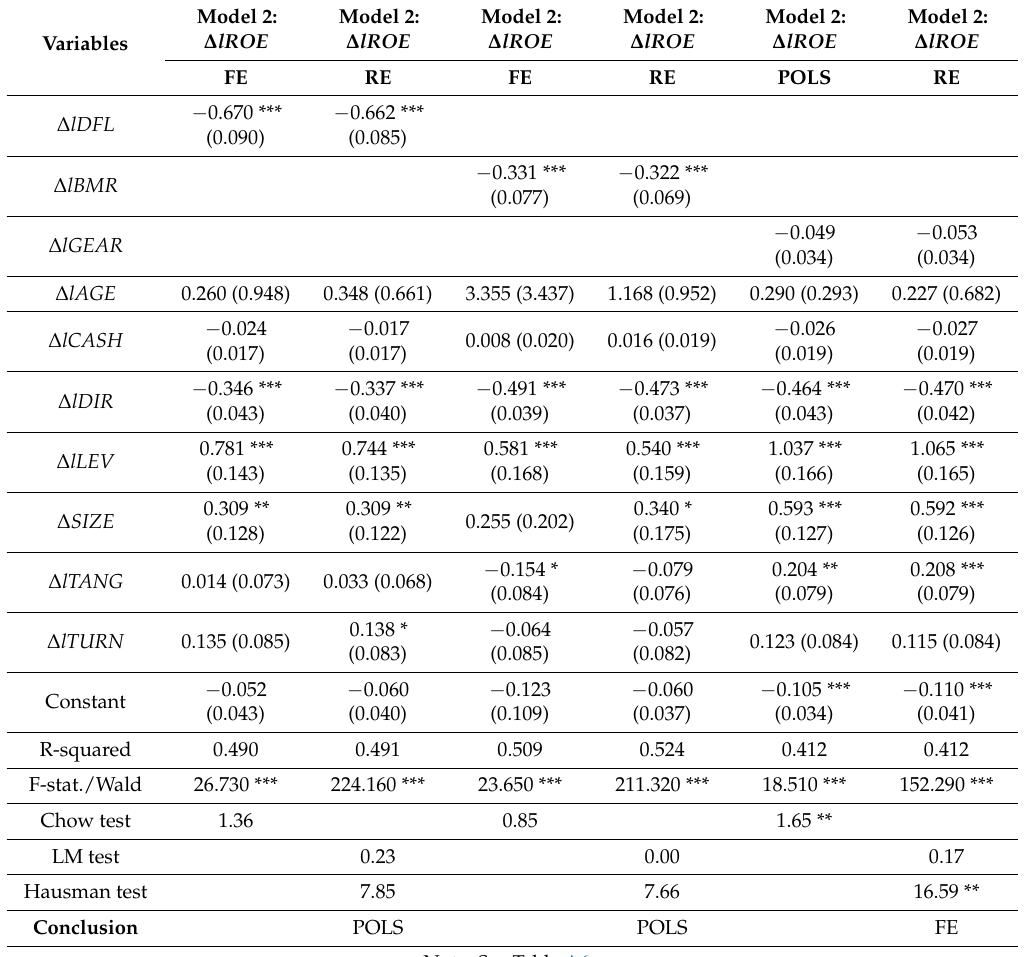
Table A7. Selection of the most appropriate estimator for the robustness analysis (Model